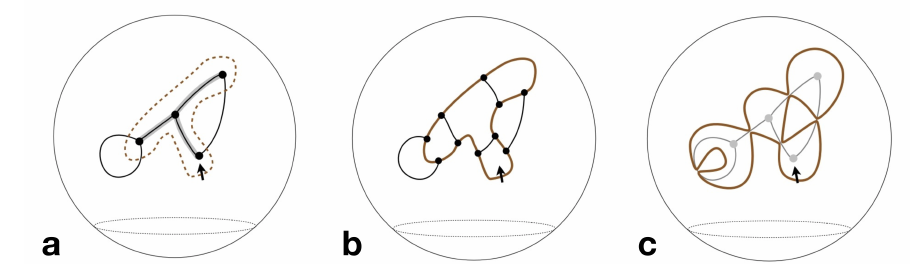
Figure 5. Alternate interpretations. A Mullin code describes: ( a ) A tree-rooted plane graph, ( b ) a 3-regular plane graph with a rooted Hamiltonian circuit, or ( c ) a 4-regular plane graph with a rooted A-trail , or non-crossing Eulerian